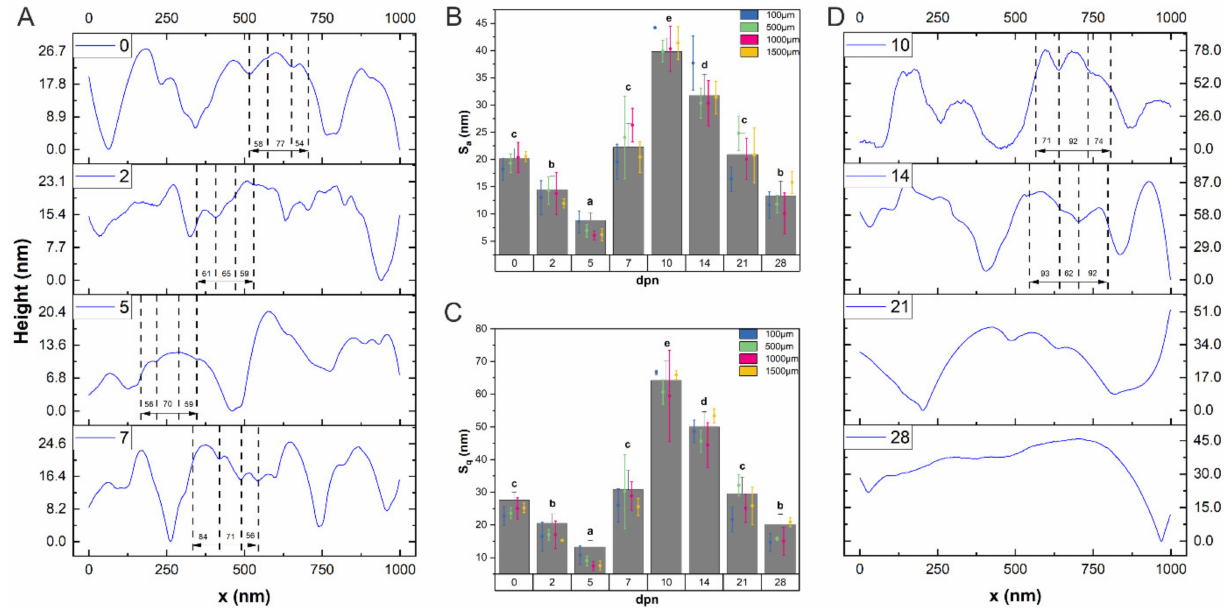
Figure 4. Averaged height profiles over the scanning distance of 1 µ m ( A , D ). Average roughness S a ( B ) and root mean square roughness S q ( C ) with corresponding statistics according to days (columns) and distance (error bars plot). The dashed lines in the height profiles present borders between the chosen HA crystallites, which are not marked for the 21st and 28th day of postnatal life (dpn). Data are presented as mean ± SD. Different letters indicate significant differences in groups (at p <